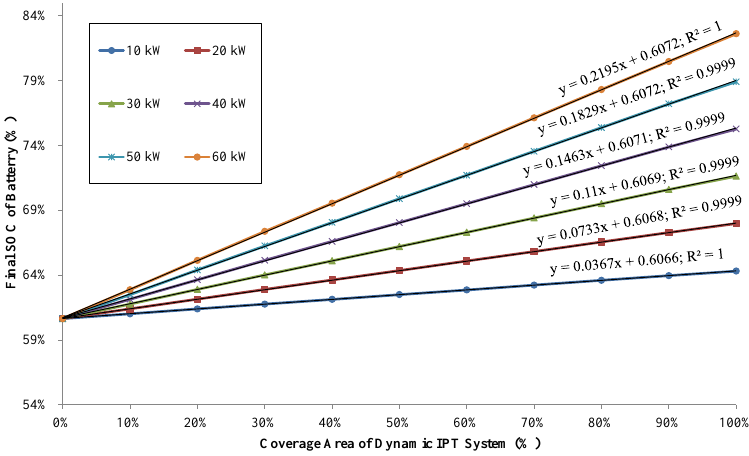
Figure 6. Final SoC versus road coverage area for different power levels of the dynamic IPT